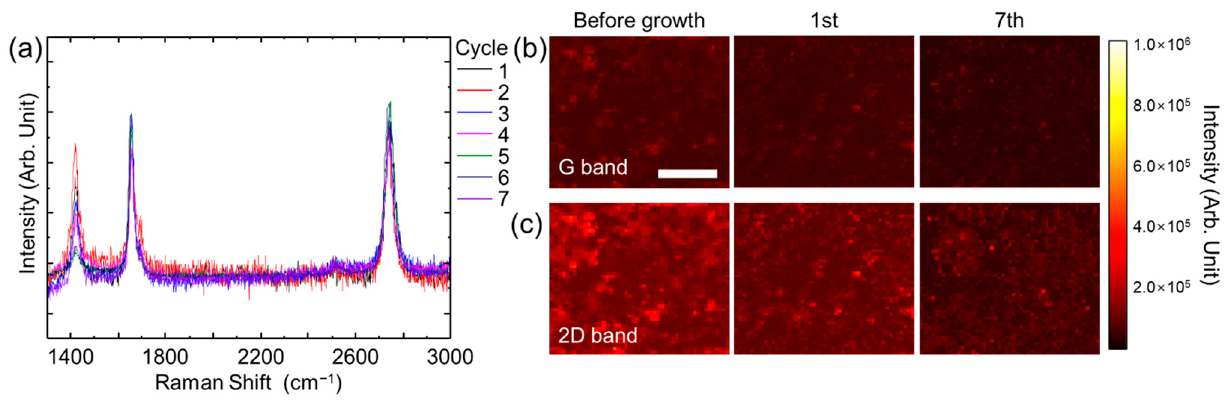
Figure 6. ( a ) Raman spectra of graphene layer over 7 times of repeated hydrothermal growth and removal of ZnO NWs. ( b ) Raman map of G and ( c ) 2D bands before the growth of ZnO NWs and after repetitive growth of ZnO NWs up to 7 times.